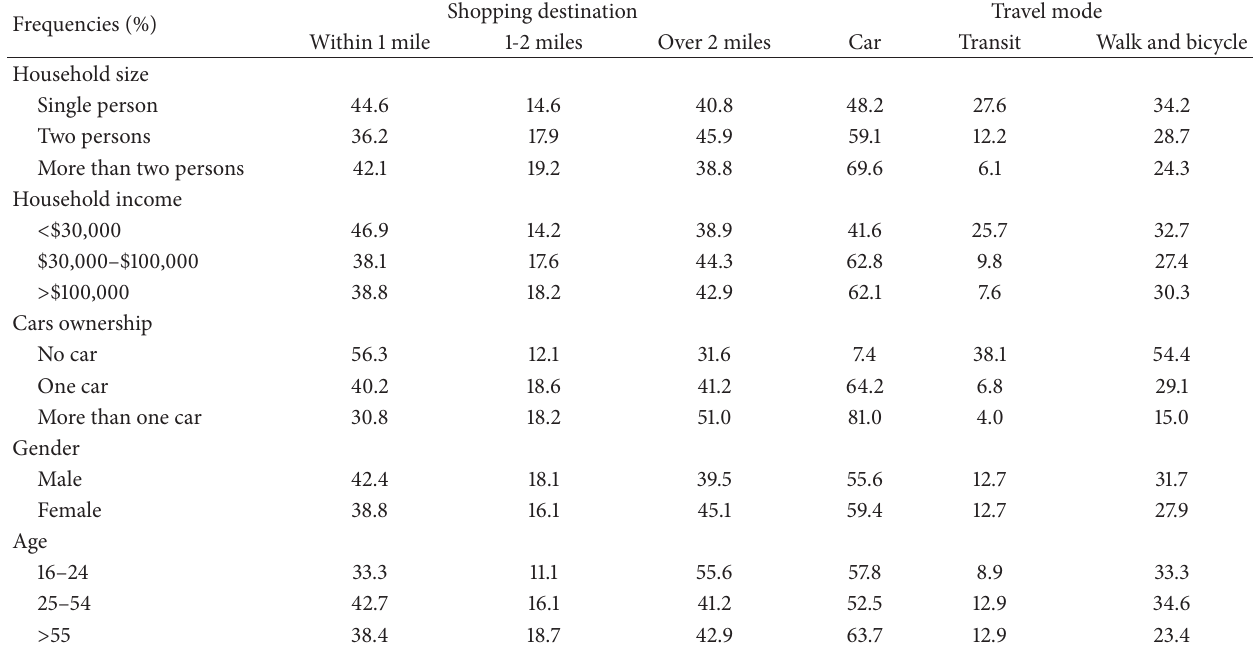
Table 3: Sample profiles stratified by shopping destination and travel mode ( 𝑁 = 975